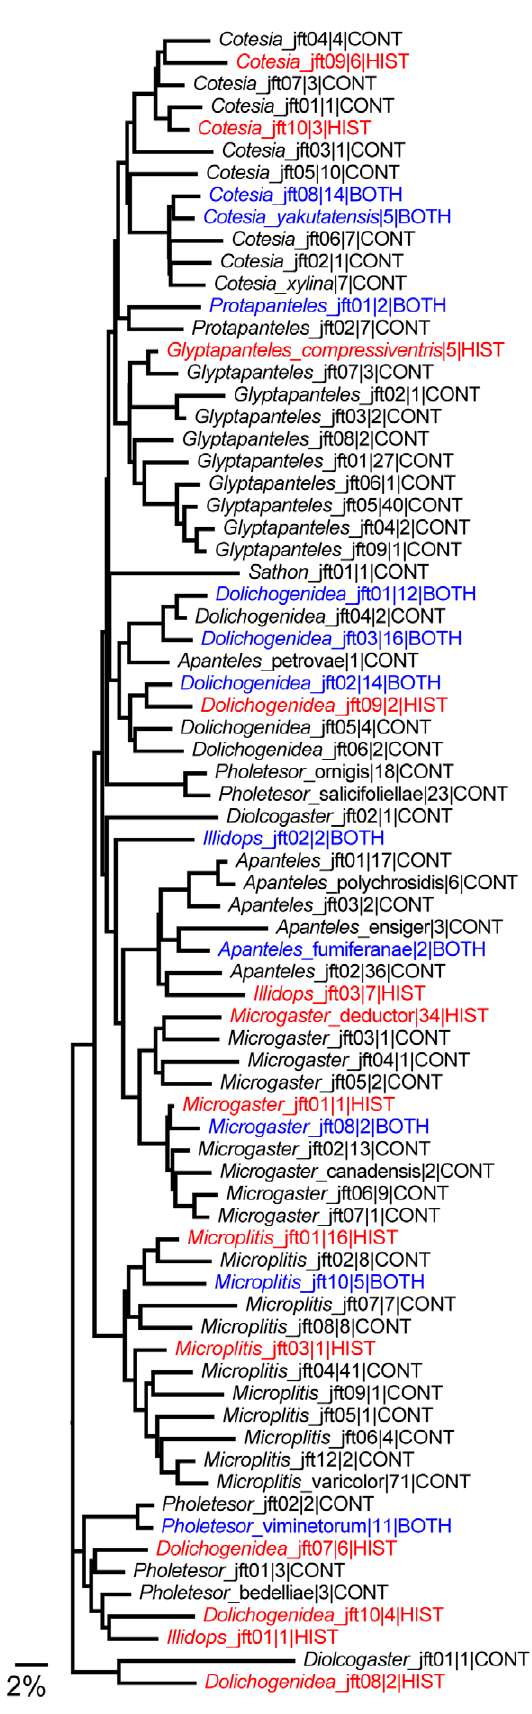
Figure 2. Neighbour-joining tree (K2P distance model) for Churchill Microgastrinae with single specimen per species. Tips are labelled: species name|sample size|collection period. Labels in red indicates specimens present only in historical collections (HIST), blue labels indicate a species present in both historical (BOTH) and contemporary collections, while labels in black indicate species only found in contemporary collections